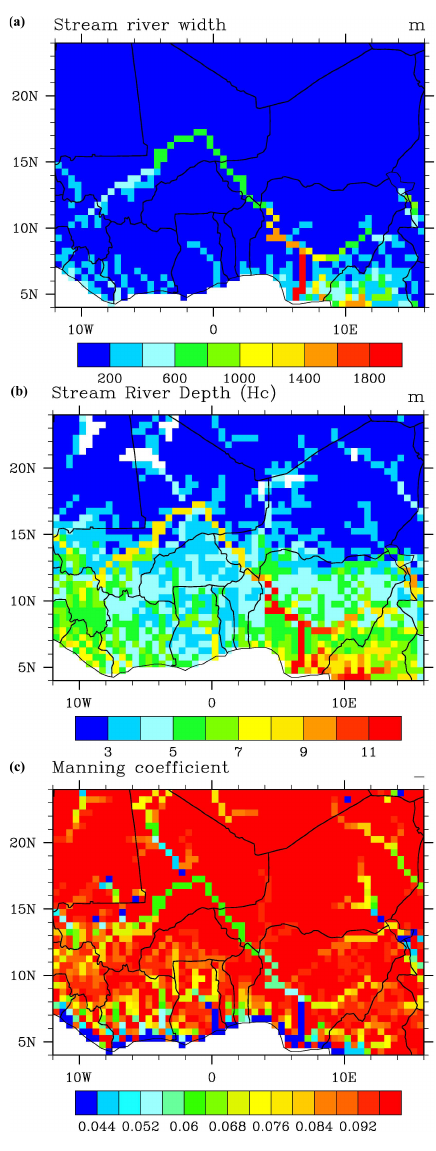
Fig. 3. Some TRIP parameters. Spatial distribution of the river width (up left), the river depth (up right) and the Manning coeffi- cient